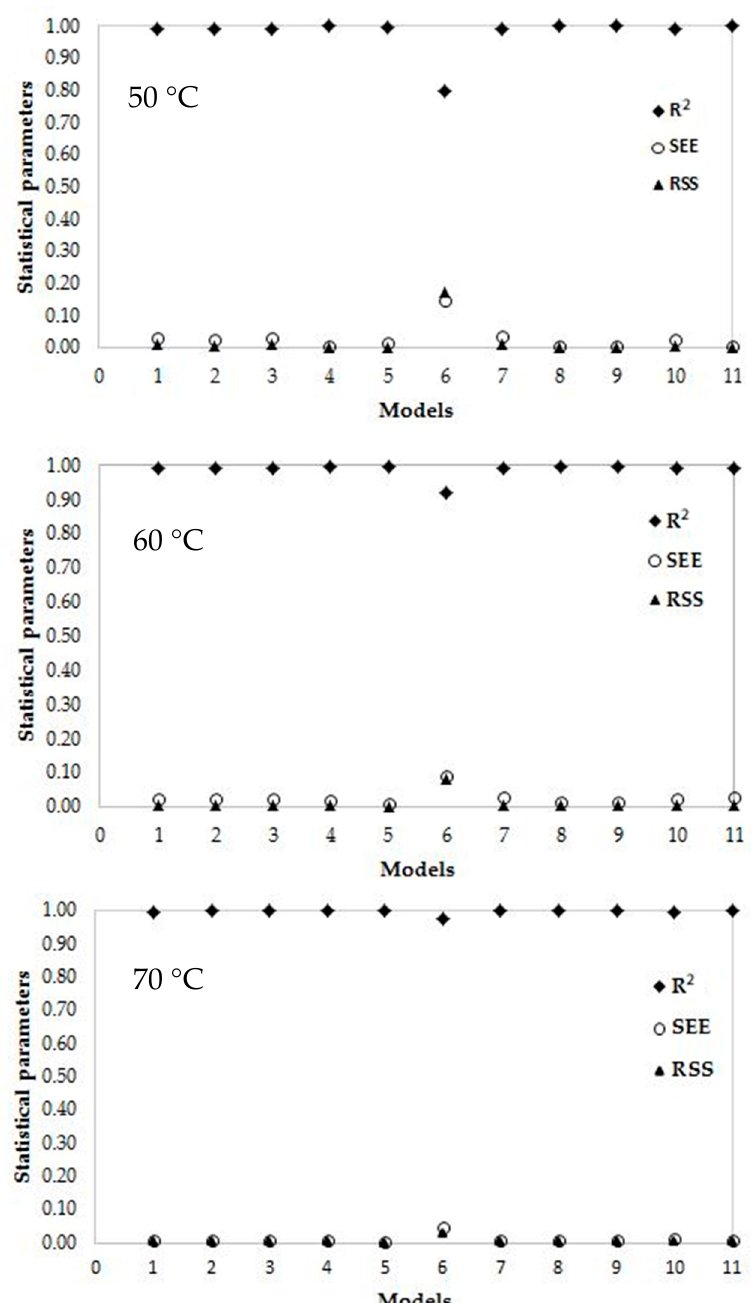
Figure 6. Statistical parameters of each model for different infrared (IR) drying temperatures. Where MR is the moisture ratio (dimensionless); k , the drying rate constant (h − 1 ); t , the time (h) and a, n and b are experimental constants. The determination coefficient (R 2 ), residual sum of squares (RSS) and standard error of estimate (SEE). Thus, the Midilli et al. [34] model may be assumed to represent the drying behavior of Linden leaves for 50 °C and 60 °C temperatures. It was emphasized that the Midilli et al. model [34] exhibited similar results in many other studies such as eggplant [31], kaffir lime leaves [51], carrot slices [56], Moroccan rosemary leaves [40], and pepper [20]. In addition, two- term and Logarithmic models gave relatively good results (Table 2 and Figure 6). Doymaz, I [57] surveyed four different thin-layer drying models (Lewis, Henderson, and Pabis, Modified Page, and logarithmic) and used determination coefficient, reduced R 2 , and RMSE for comparing. According to the results, logarithmic model showed a good fit than the other models.